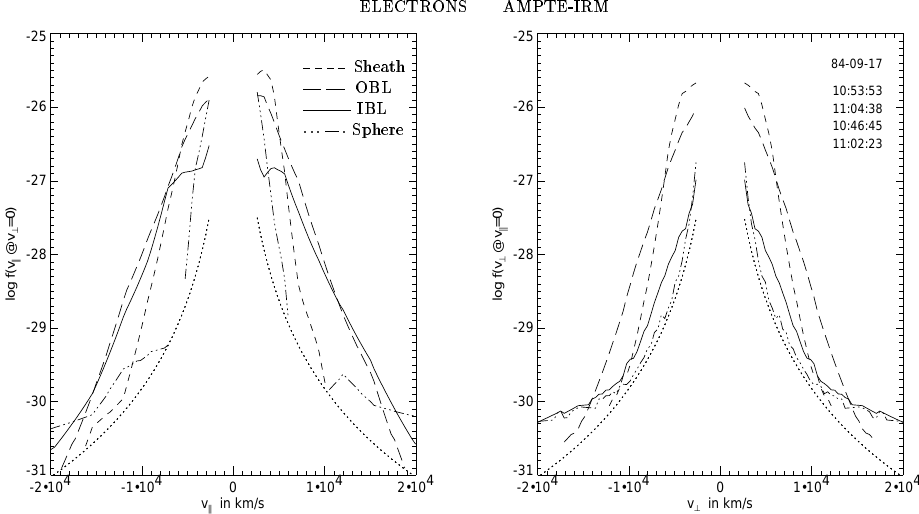
Fig. 1. One-dimensional cuts through the electron distributions measured on 17 September 1984. The measurements are taken in the magne- tosheath at 10:46:45 (short dashed line), in the outer boundary layer at 10:53:53 (long dashed line), in the inner boundary layer at 11:02:23 (solid line), and in the magnetosphere proper at 11:04:38 (dash-dotted line). The left diagram shows the phase space density f e (in cm − 6 s 3 ) = 0 . The dotted line gives the detection as a function of v for v ⊥ = 0 , and the right diagram shows f e as a function of v ⊥ for v k k